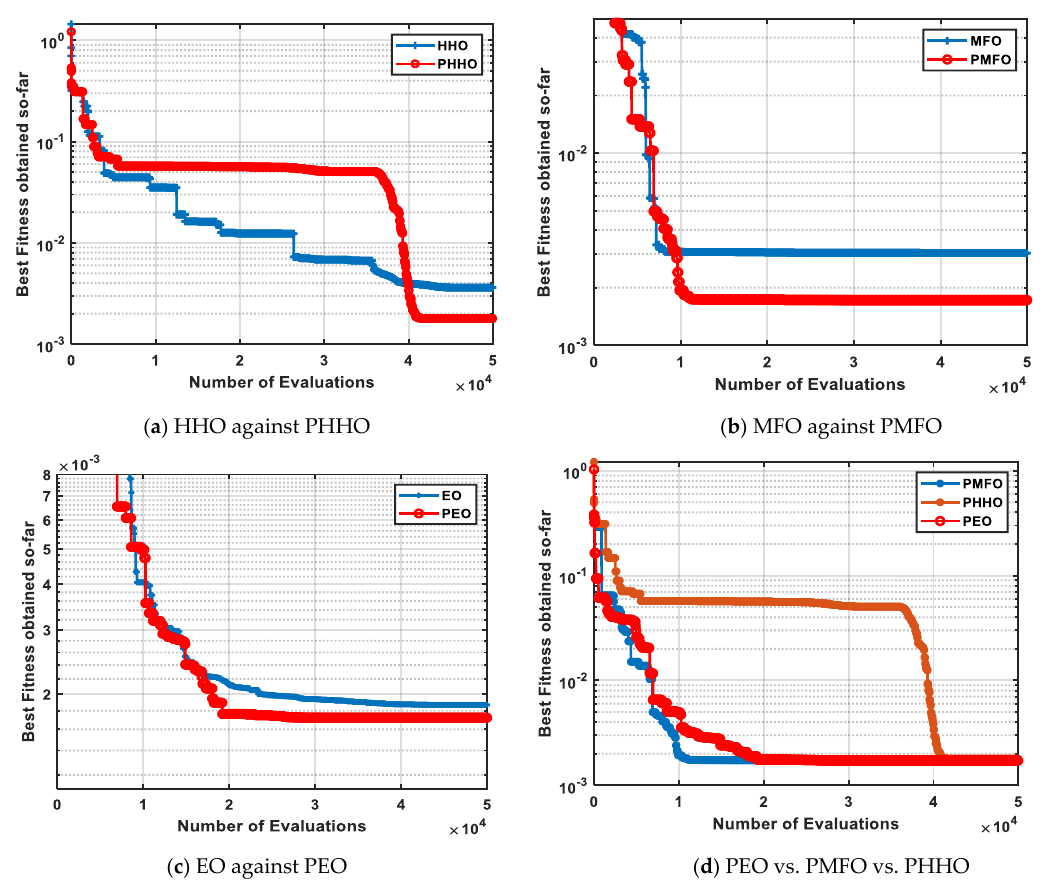
Figure 8. Convergence curves among algorithms in STM6.